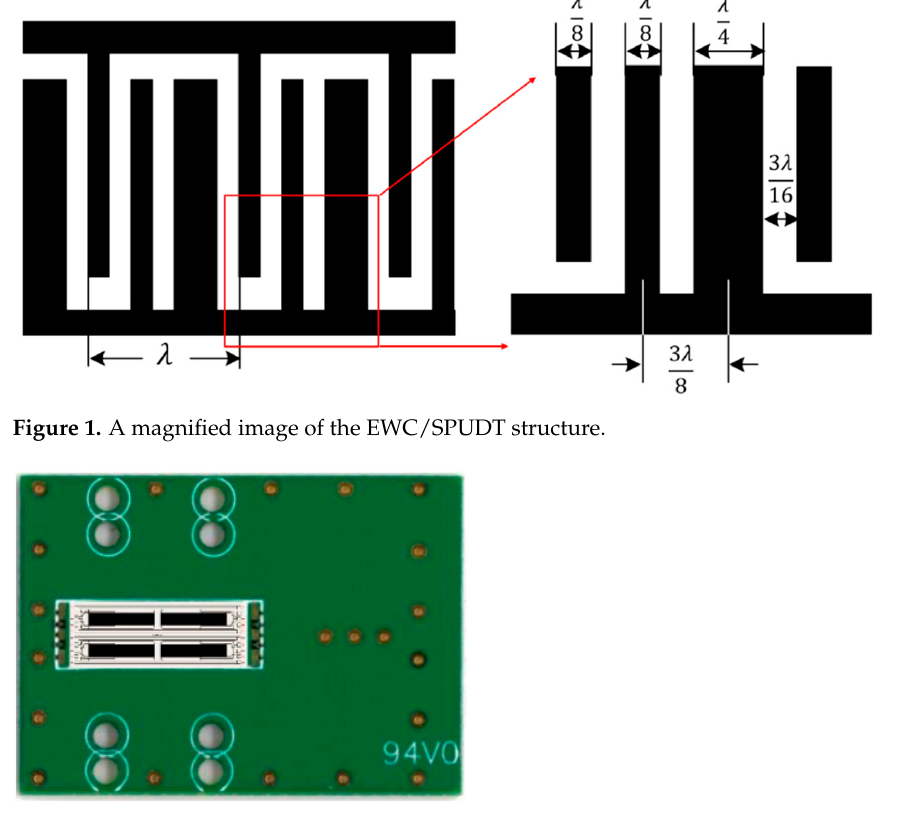
Figure 2. The EWC/SPUDT SAW sensing chip.